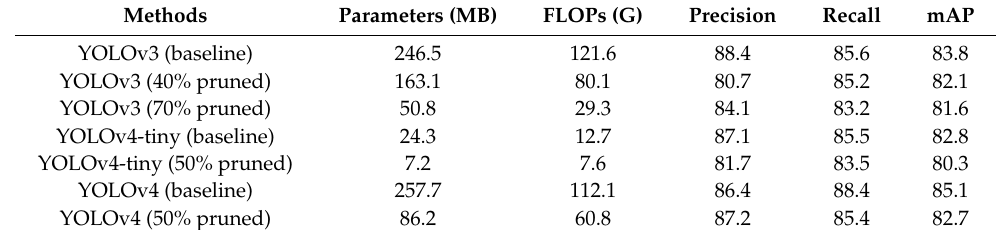
Table 2. Performance evaluation on the NWPU VHR-10 dataset.